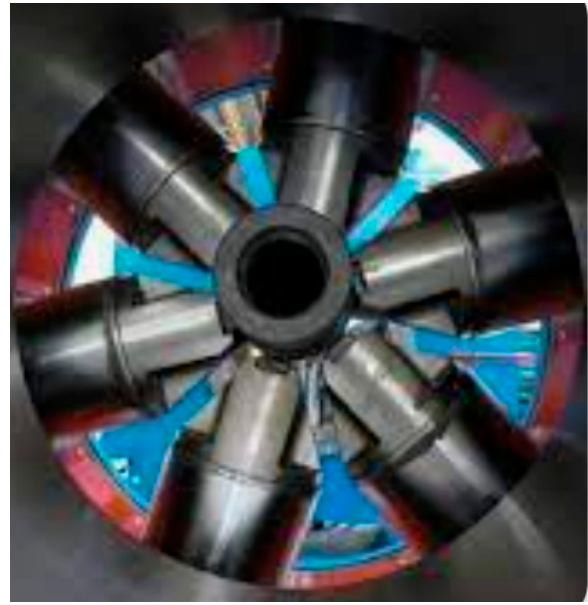
Figure 7. Rotational pipe torque machine [81].